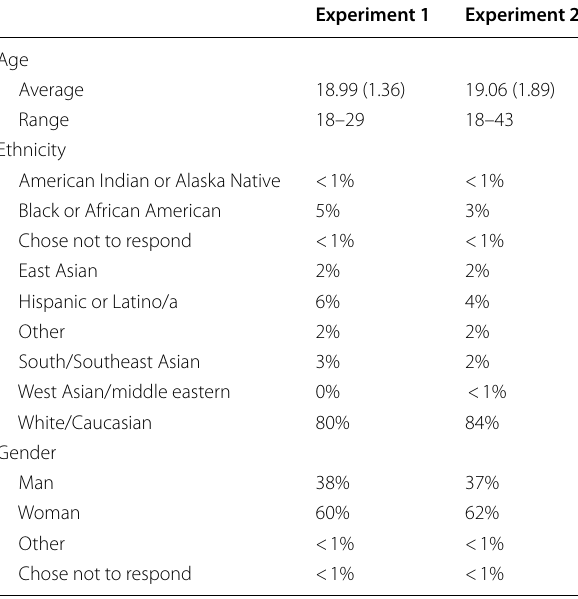
Values in parentheses represent standard deviations